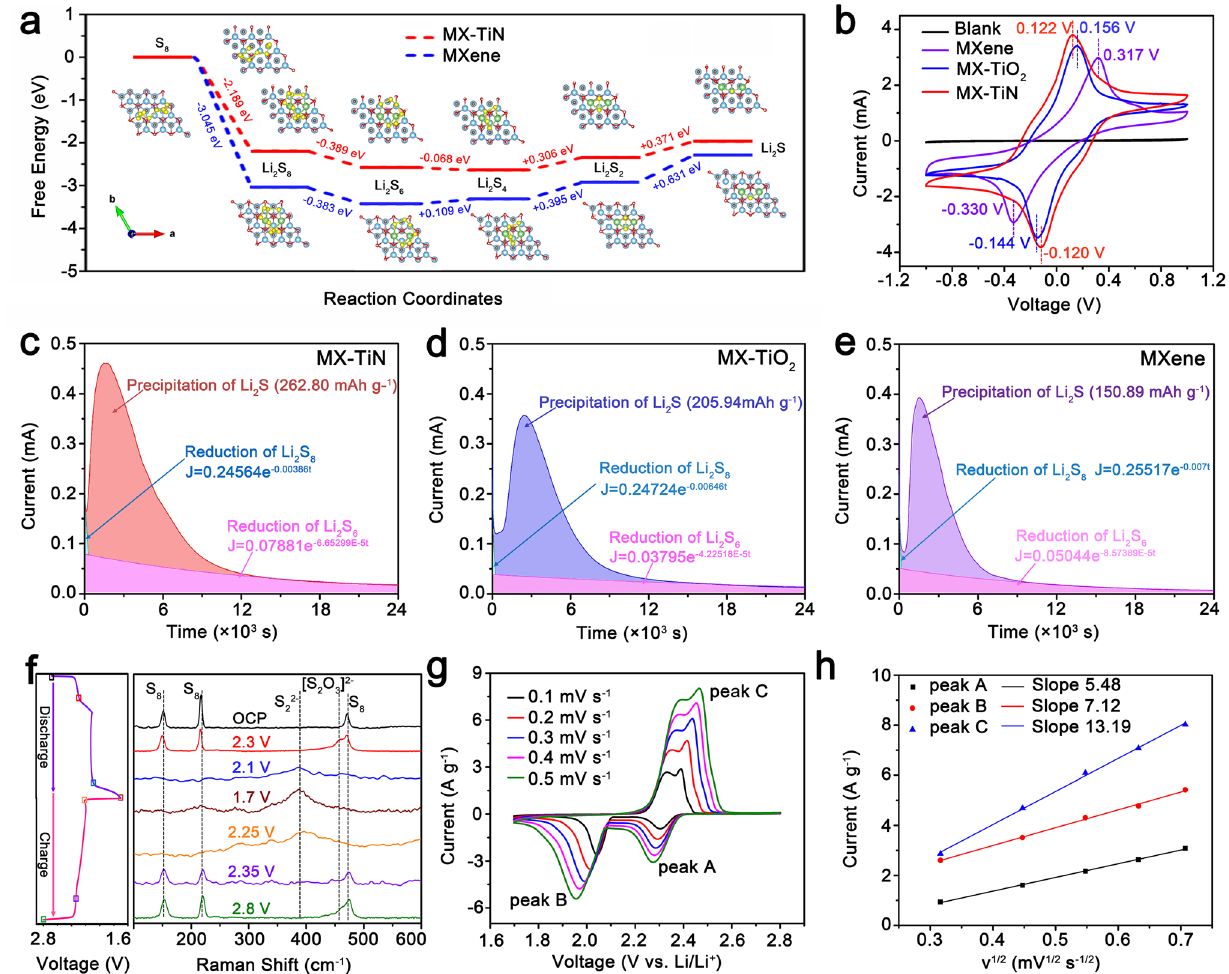
Fig. 4 a The Gibbs free‑energy profiles of LiPSs conversion on MX‑TiN and pure MXene. b CV curves of MXene, MX‑TiO 2, and MX‑TiN symmetric cells with and without Li 2 S 4 electrolyte. Potentiostatic discharge profile at 2.05 V on c MX‑TiN electrode, d MX‑TiO 2 electrode, and e MXene electrode with Li 2 S 8 electrolyte for evaluating the nucleation kinetics of Li 2 S. f First discharging/charging profiles and corresponding ex‑situ Raman spectra at different potentials of S/MX‑TiN cathode. g CV profiles at different scan rates of S/MX‑TiN cathode and h correspond‑ ing I – v 2 slope